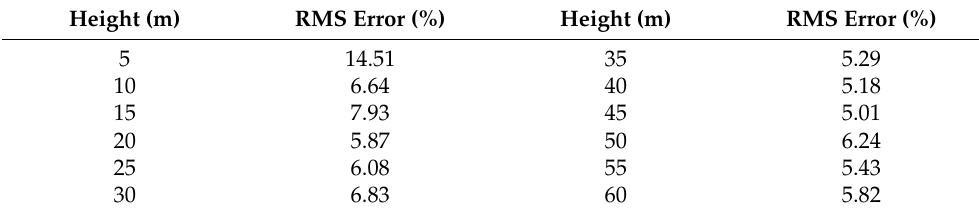
Table 1. RMS error of the identified wind loads on the continuous